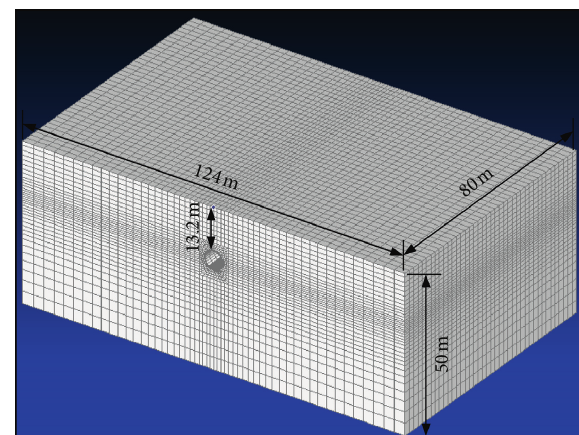
Figure 20: The 3D numerical model.